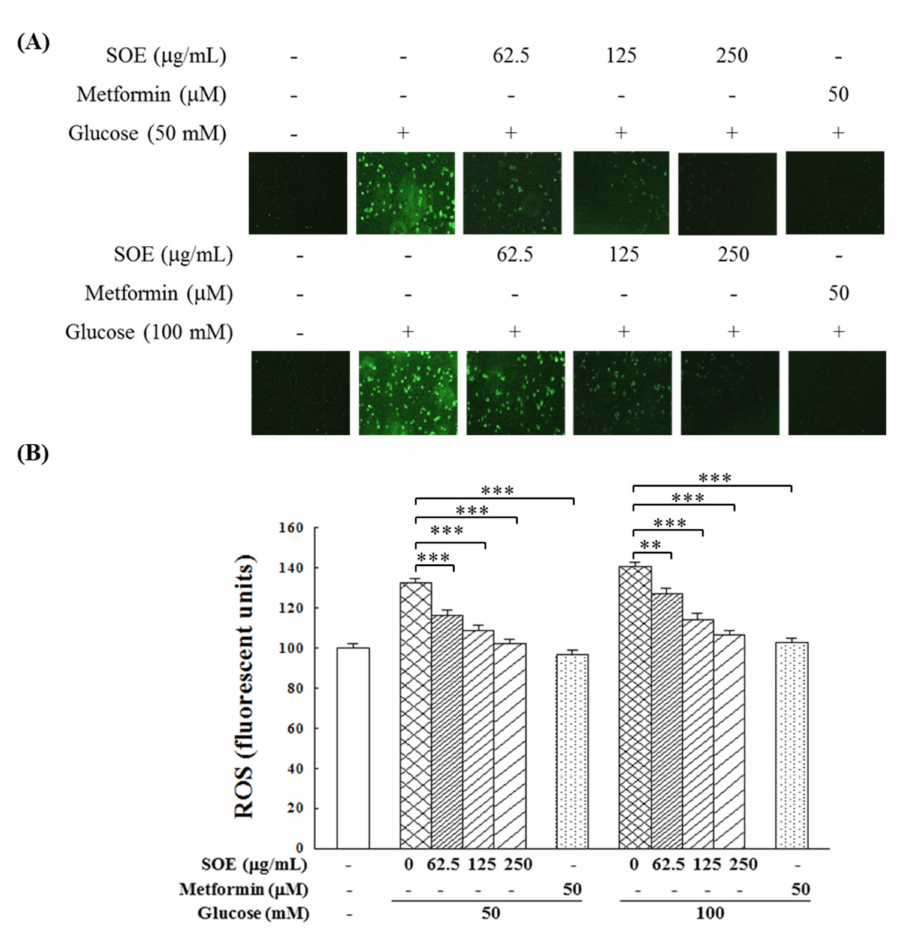
Figure 2. Effect of SOE on the formation of ROS in RIN-m5f β -cells under HG-induced condi- tions. ( A ) Changes in the intracellular ROS levels indicated by the DCFH 2 -DA fluorescence in- tensity. ( B ) Fluorescent quantitation. The β -cells were cultivated in 96-well plates at a density of 1 × 10 5 cells/well for 24 h, and the indicated concentration of SOE was added under the stimulation of 50 mM or 100 mM glucose. After 24 h treatment, the cells were washed with PBS and incubated with 5 µ M DCF-DA for another 30 min at room temperature. Fluorescence of this compound was measured by a microplate reader. The experimental data were calculated from the results of five repeated experiments. The statistically significant differences compared with the vehicle (group 0) are expressed as ** p < 0.01, and *** p < 0.001. The positive control was 50 µ M